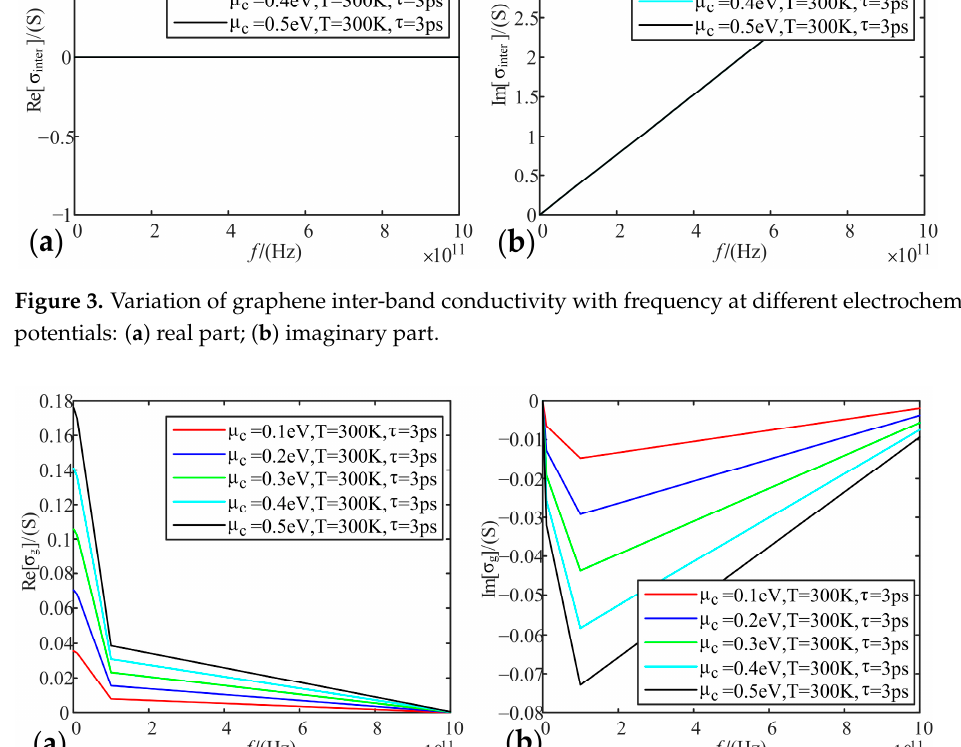
Figure 5. Variation curve of graphene total conductivity with frequency at different temperatures: ( a ) real part; ( b ) imaginary part. Fixing electrochemical potential is 0.3 eV, and the temperature is 300 K; we analyzed the variation of real and imaginary parts of graphene conductivity with frequency, when the relaxation time was taken as 1 ps, 2 ps, 3 ps, 4 ps, and 5 ps, respectively. Figure 6 shows that the real part of conductivity decreases with increasing frequency. In particular, the slope of the real part changes more abruptly at 100 GHz. Meanwhile, when the frequency is less than 100 GHz, the real part of conductivity increases with the increasing relaxation time. When the frequency is greater than 100 GHz, the real part of conductivity is the largest when the relaxation time is 2 ps, followed by 1 ps, and then 3 ps, 4 ps, and 5 ps. As for the imaginary part of the conductivity, it decreases with increas- ing relaxation time. Unlike the real part, when the frequency is above 100 GHz, the imag- inary part increases with the increasing frequency.